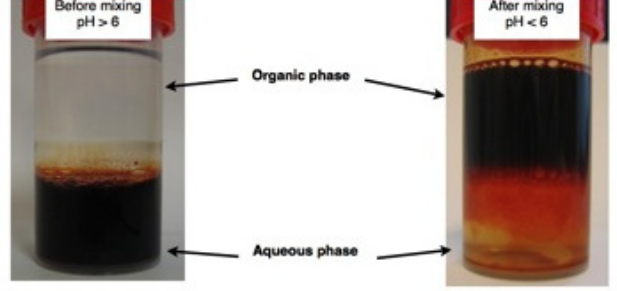
Figure 2. Vials containing the two phases before ( left ) and after ( right ) pH decrease in the aqueous